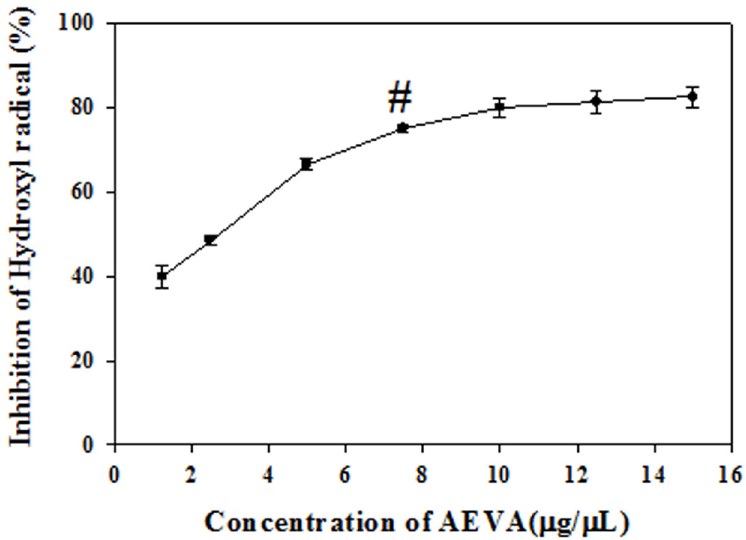
Fig 4. Hydroxyl radical scavenging activity of AEVA. Curve is obtained by plotting various concentrations of AEVA (1.25, 2.5, 5, 7.5, 10, 12.5, and 15 μ g/ μ L) against percent inhibition. “ # ” indicates the optimum concentration of AEVA at which it exhibits maximum inhibition. Values are mean ± SE (n = 4).